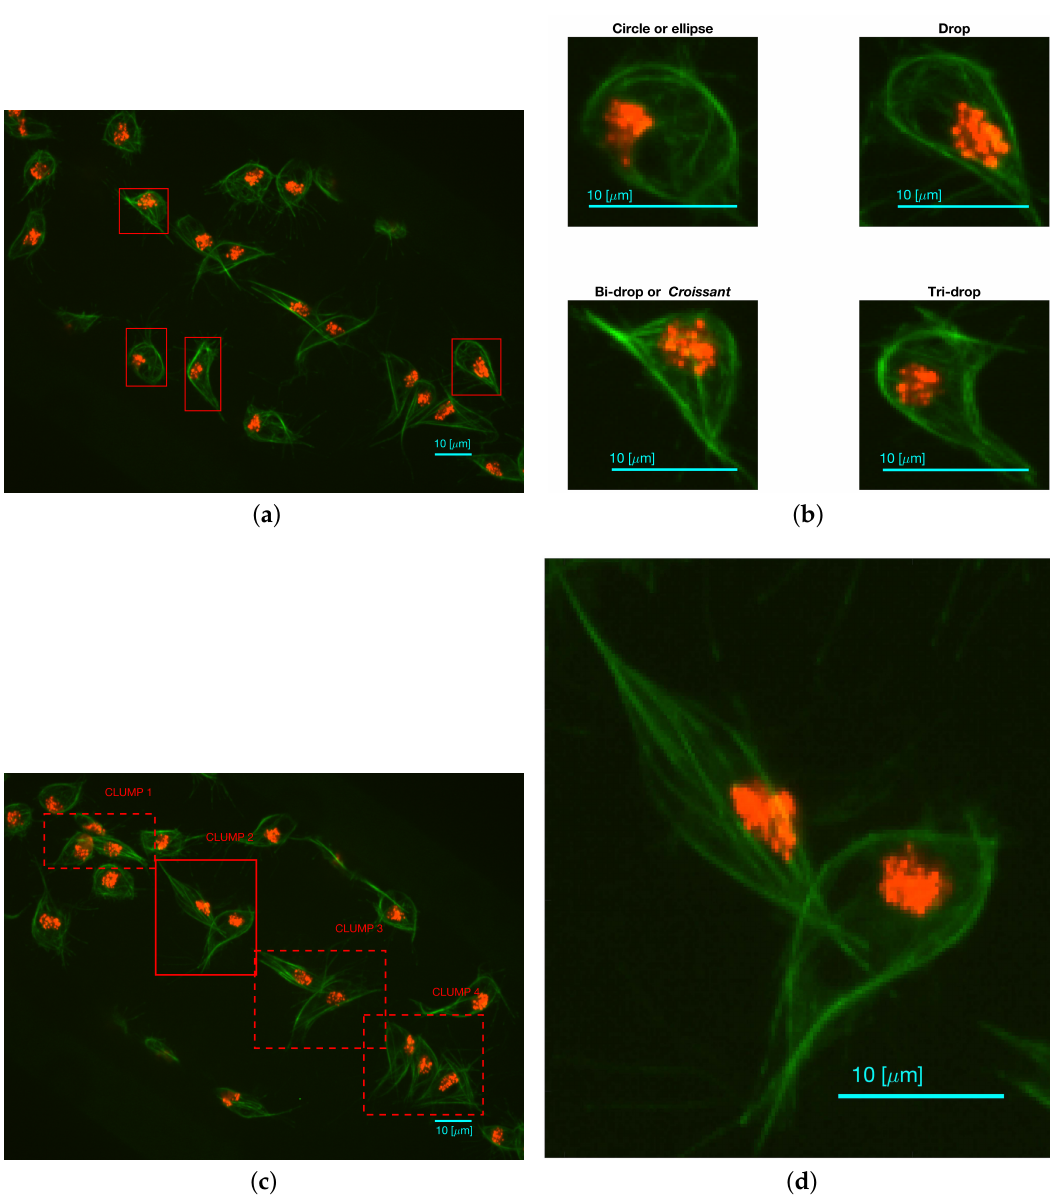
Figure 1. Two representative time frames displaying examples of cell shapes and overlapping. ( a ) Full frame with (red) squares highlighting the cells that display the aforementioned shapes; ( b ) Detail of each cell; ( c ) Presents the full frame with (red) squares highlighting all regions where instances of overlapping cells (clumps) are shown and labelled for easy reference; ( d ) Detail of CLUMP 2, present in ( c ). Bars: 10 µ m. ( c , d ) are reproduced with permission from [17]. Ground Truth of Macrophages